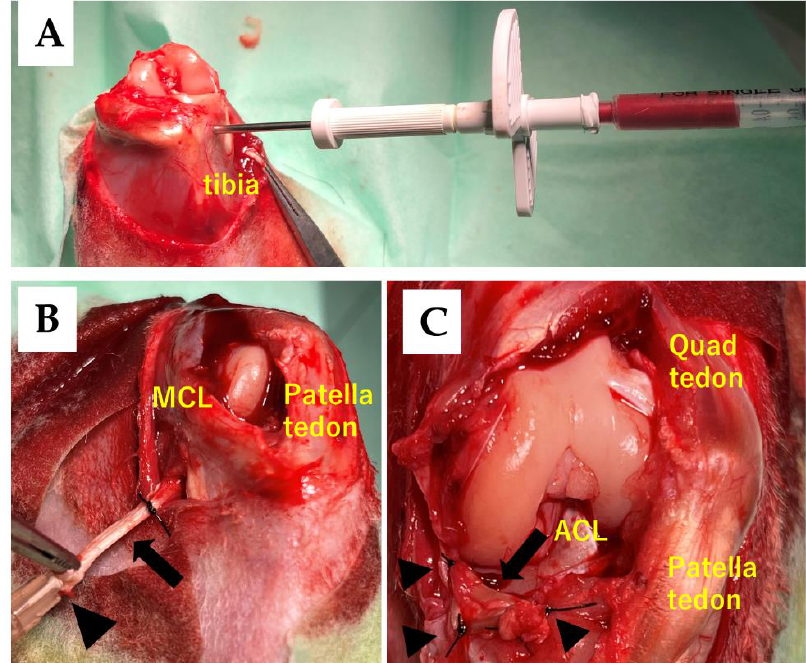
Figure 8. Method of injection into the semitendinosus tendon and the replacement of the meniscus tissue. ( A ) Bone marrow aspirate (BMA) was obtained from the lateral side of the tibial of the knee joint using a 15-gauge Bone Marrow Harvest Needle. ( B ) BMA was injected using a 26-gauge needle (black arrowhead) that was inserted into the center of the rabbit’s semitendinosus tendon (black arrow). Abbreviations: MCL, medial collateral ligament. ( C ) The tendon graft was sutured using 5-0 nylon sutures (black arrowhead) to the posterior cruciate ligament (PCL), the posteromedial corner of the tibia, the anteromedial capsule, and the anterior stump of the original medial meniscus. Abbreviations: ACL; anterior cruciate ligament.